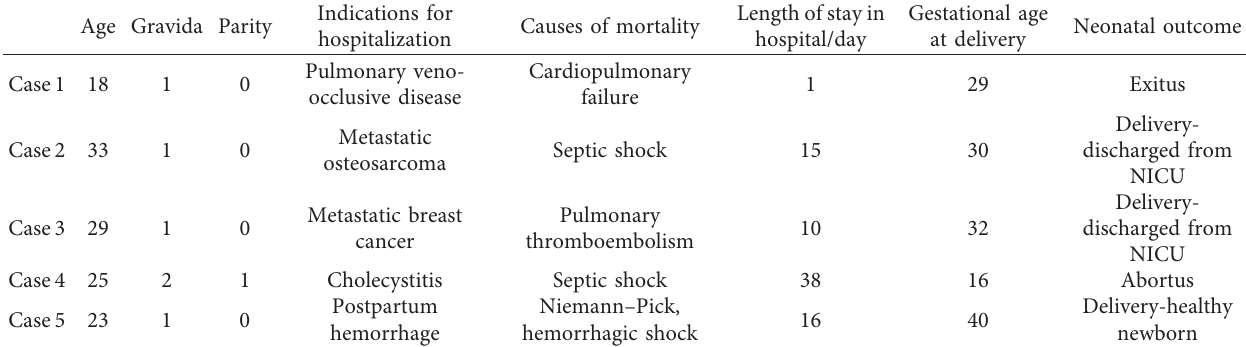
Table 1: Clinical characteristics and neonatal outcomes of the